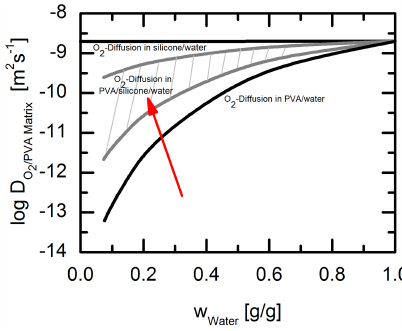
Figure 3. Schematic drawing of the oxygen diffusion coefficient as a function of the water mass fraction in the PVA/silicone composite matrix. The arrow shows increasing amounts of silicone particles in the PVA/silicone composite matrix. The hatching shows the re- gion where oxygen diffusion in the PVA/silicone composite matrix is only little influenced by the water